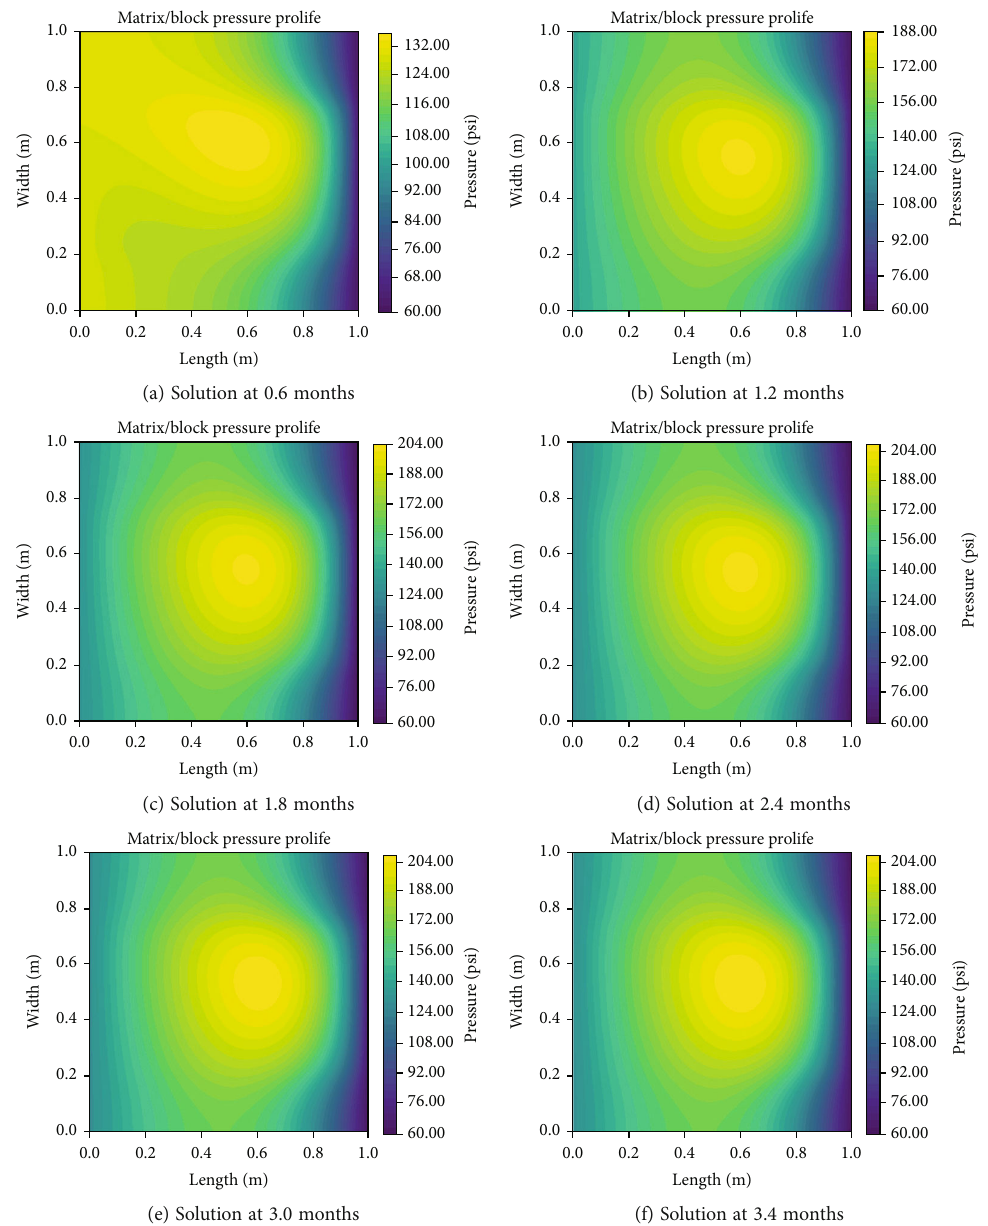
Figure 4: Pressure distribution in the matrix domain with increasing time. A quasi-steady state regime observed after the fi rst 2.4-month